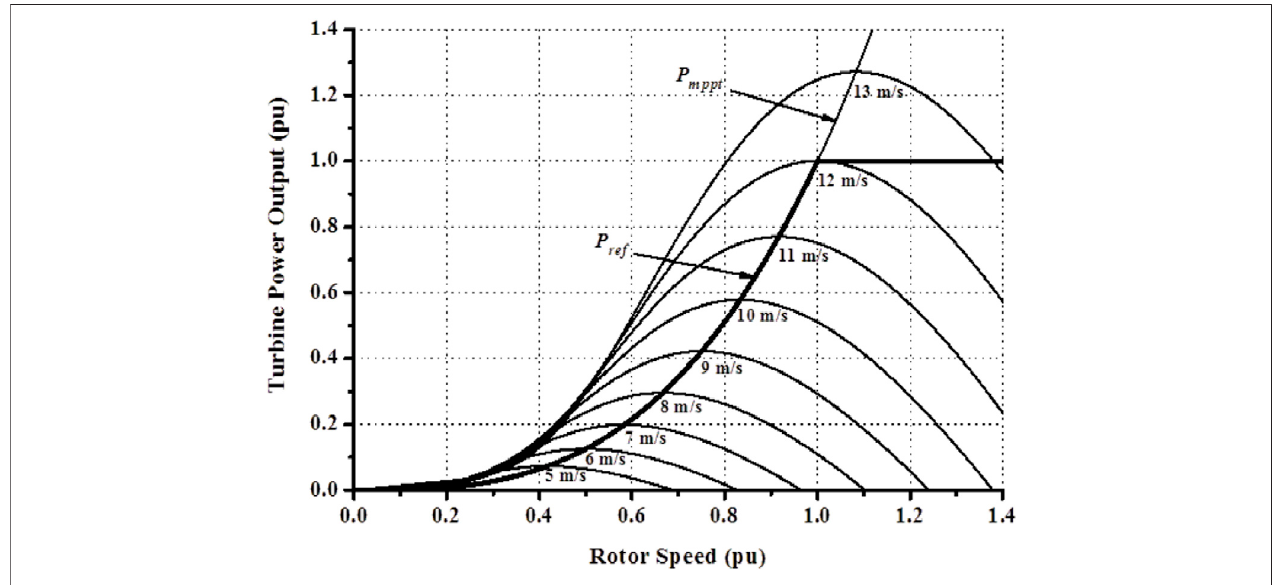
FIGURE 1 | Maximum power characteristics of the PMSG wind turbine.